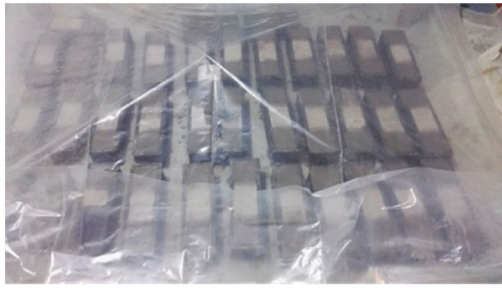
Figure 14. The specimens were cured for 28 days.